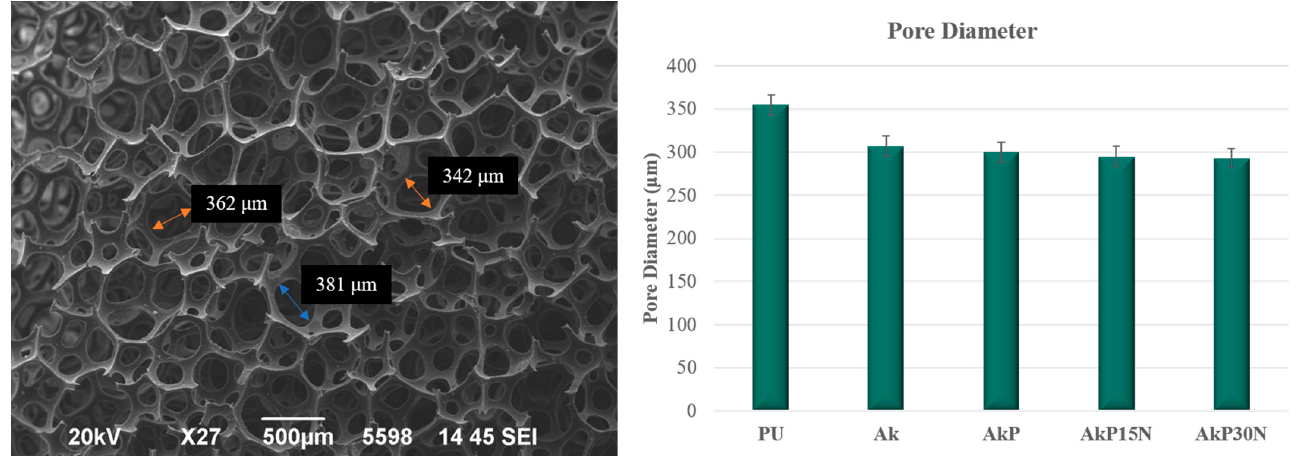
Figure 14. SEM micrograph of polyurethane foam ( left ) and the determination of the average pore size of initial polyurethane foam and synthesized scaffolds ( right